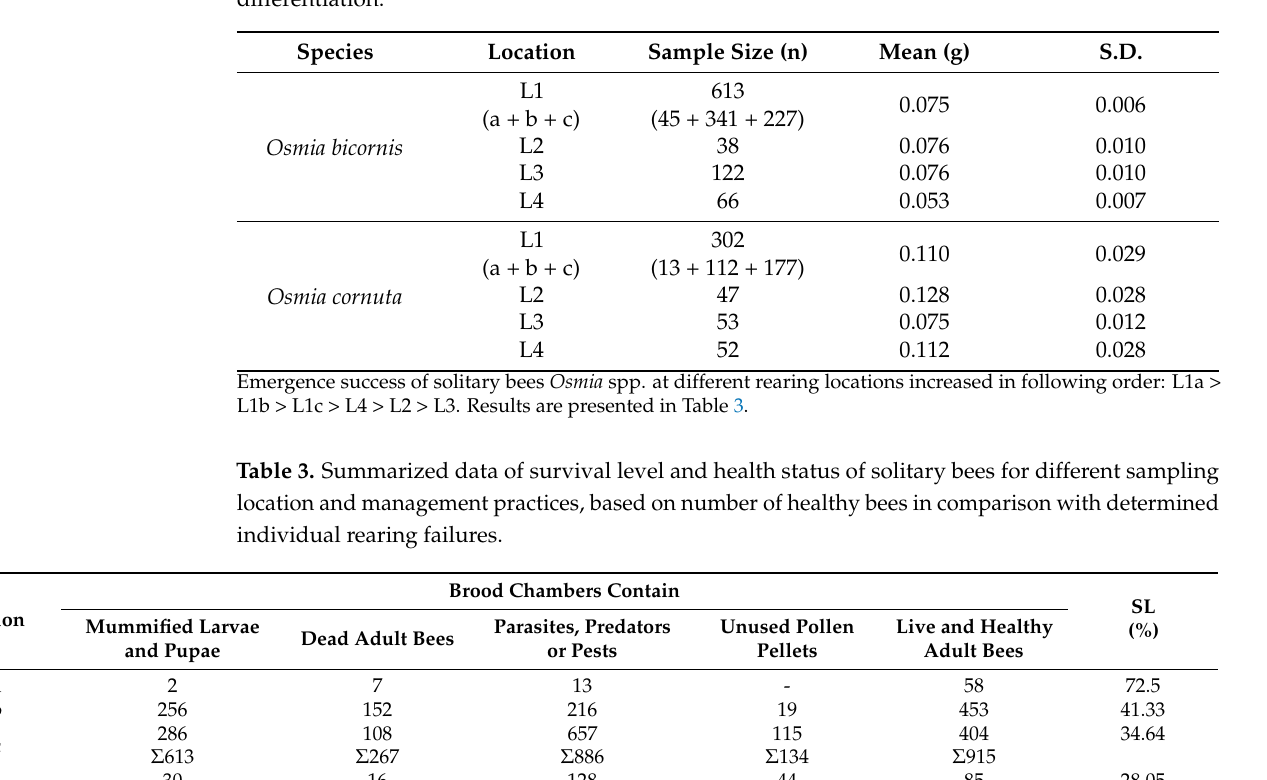
Table 2. Bee emergence weight means values based on the number of healthy bees and their species differentiation.